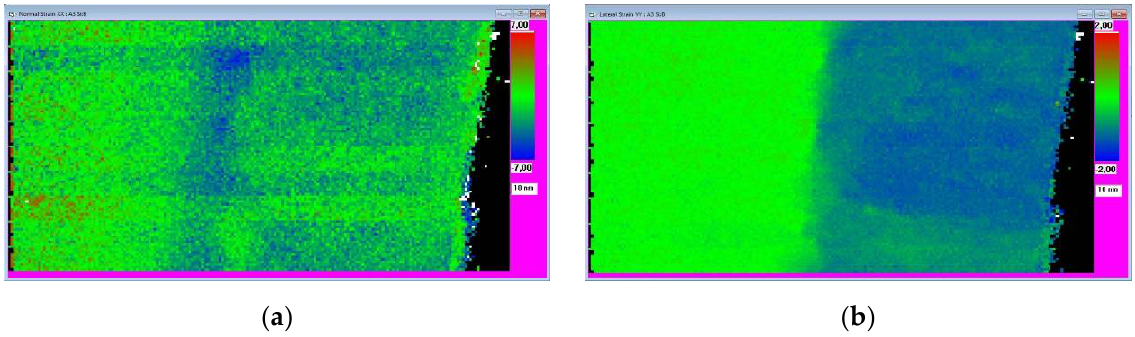
Figure 4. Two-dimensional strain distribution in an Si:B sample. The layer is on a bulk substrate. The top surface (covered with protecting Pt during FIB cutting) is on the right side of the map. The 4D-ED dataset was recorded from the area shown in Figure 1c. Pixels in the map are black, where it was impossible to fit a grid to the corresponding pattern (e.g., protecting layer). ( a ) Normal compo- nent. ( b ) Lateral component.